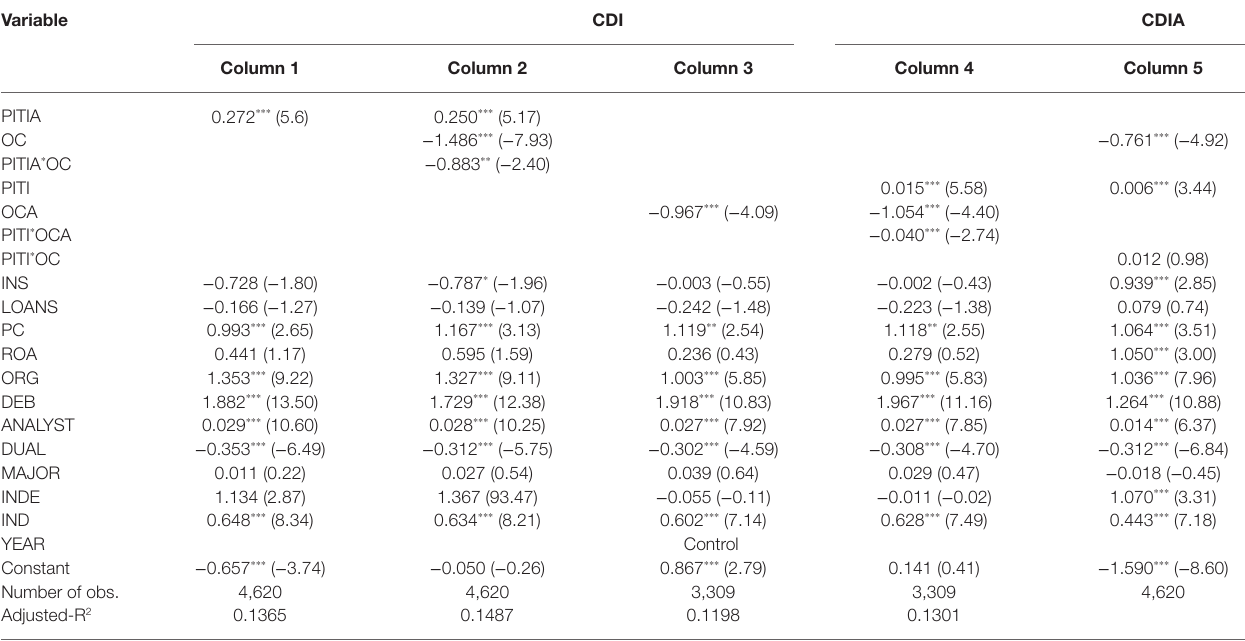
TABLE 8 | Robustness test results. Variable